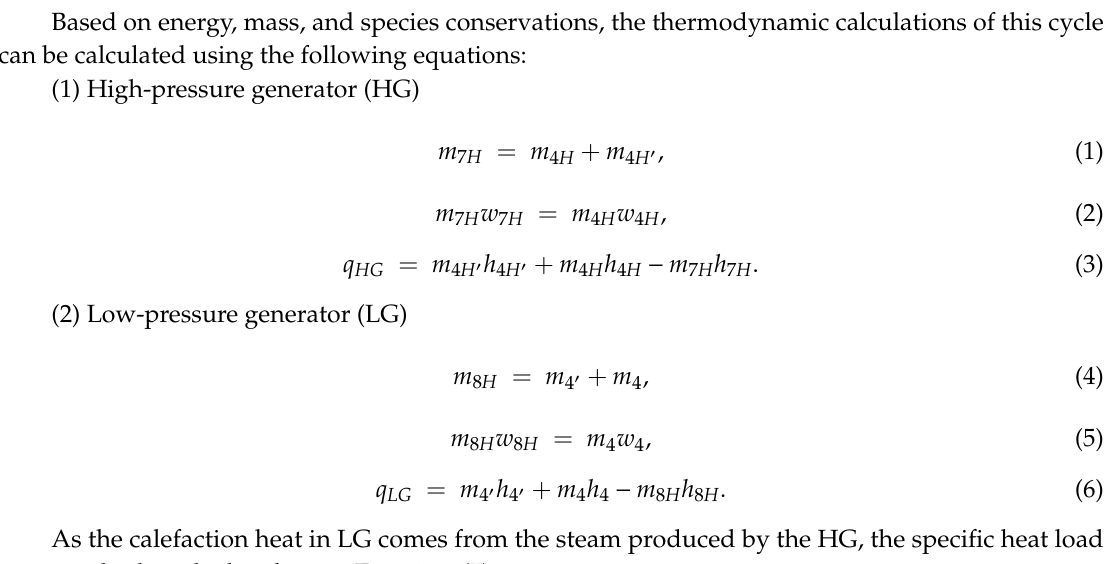
Figure 1. Schematic diagram of a double-e ff ect absorption heat pump (AHP) cycle.